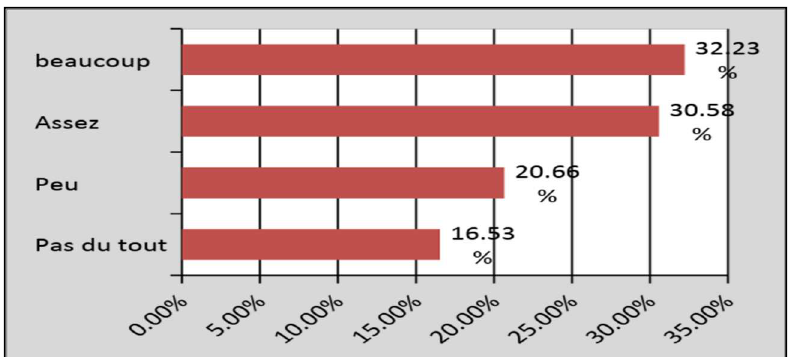
Fig. 4 La perception par les élèves de l’impact du TBI sur leurs résultats en